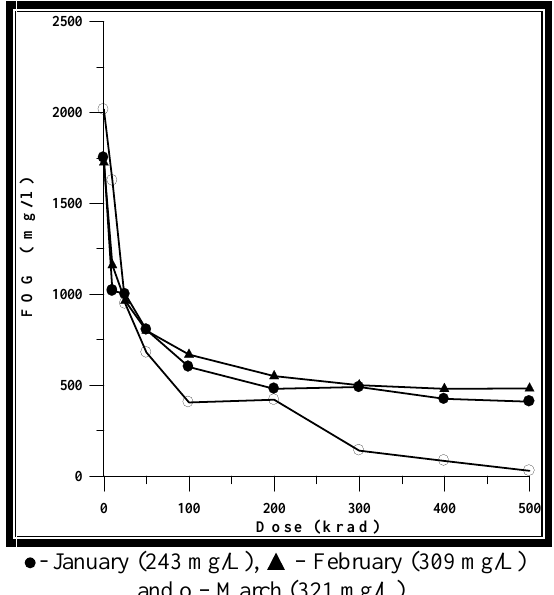
Figure 10: FOG concentration of irradiated sample of wastewater for BOD 5.